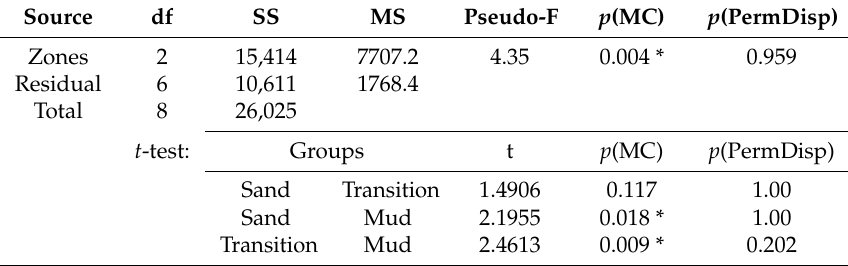
Table A4. Results of the 1-way permutational multivariate analysis of variance (PERMANOVA) and pairwise t -tests using Bray-Curtis distances testing for di ff erences on the composition of macroinfaunal communities among three sedimentary zones. p -values were adjusted using the Monte Carlo approach [ p (MC)]. p -values for tests of homogeneity of dispersion (PermDisp) are shown [ p (PermDisp)]. Asterisk indicates values under 5% probability.